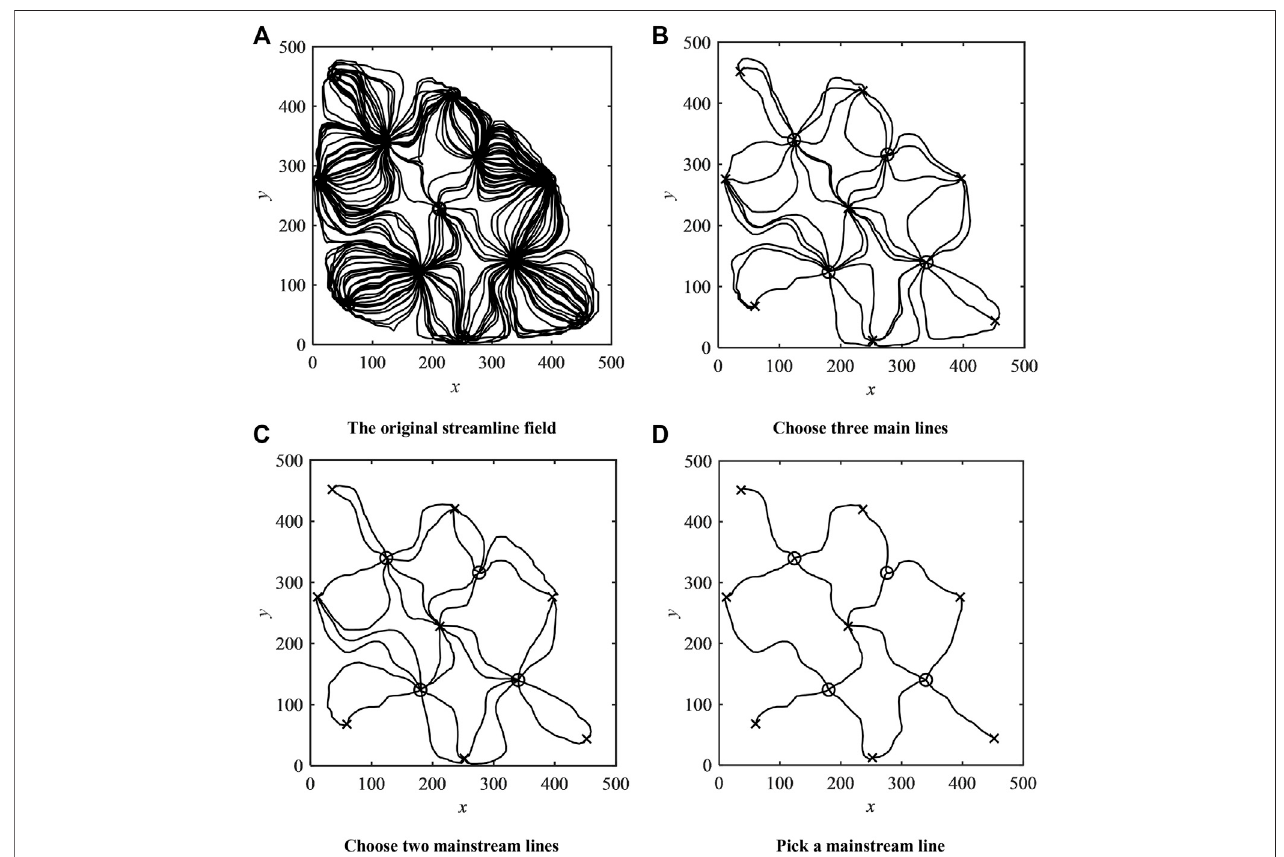
FIGURE 7 | Main streamline selection of injection and production